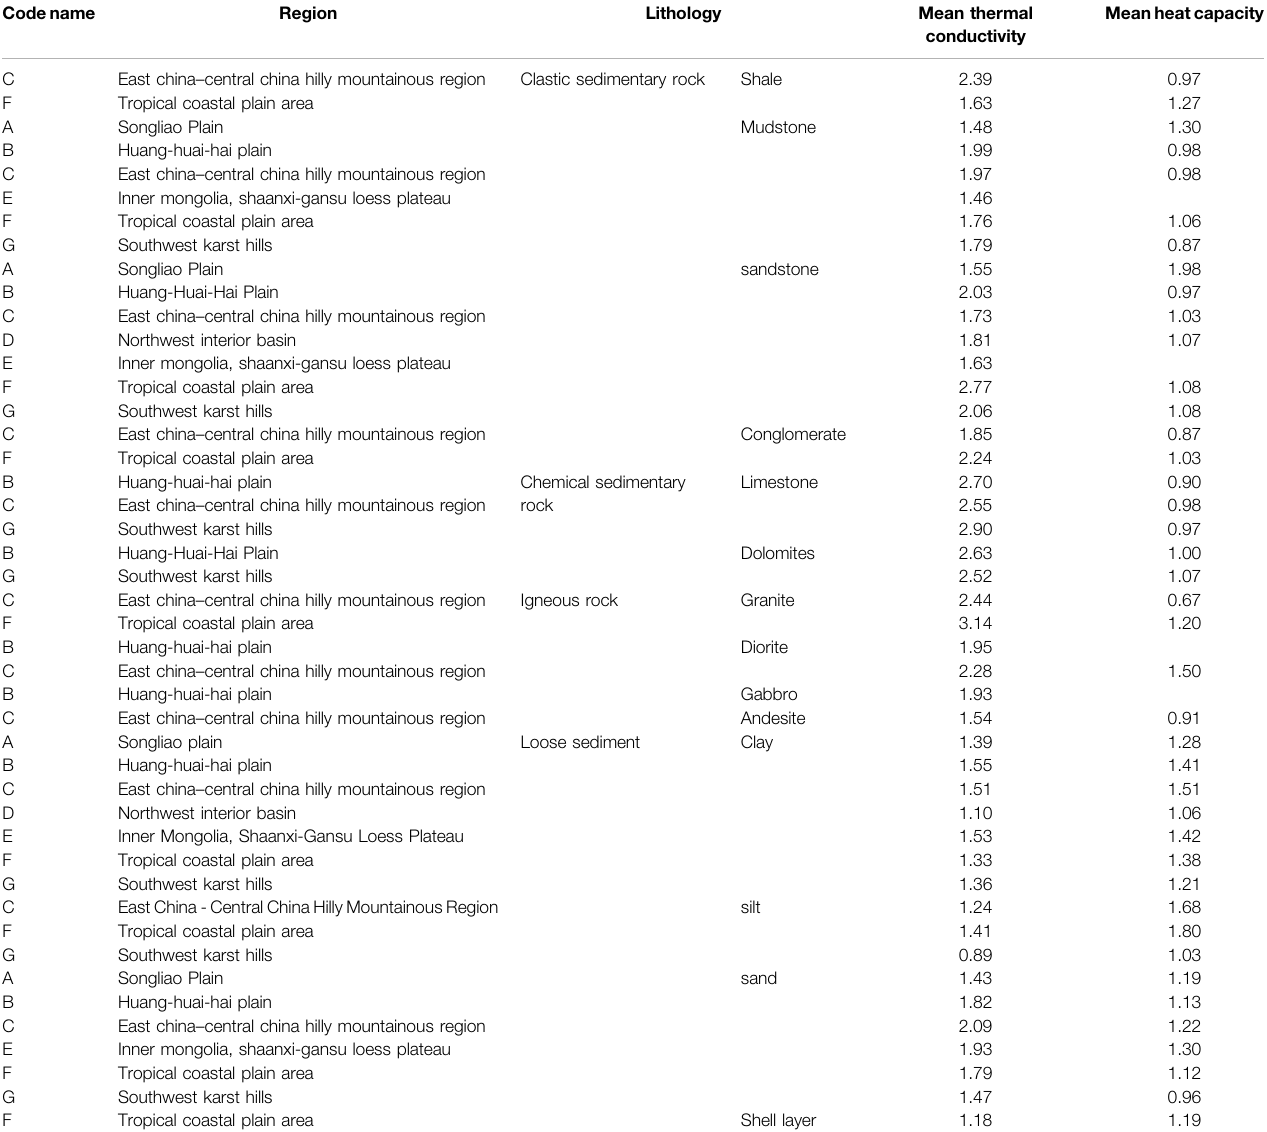
TABLE 6 | Statistical results of thermal and physical parameters of each lithology in different regions.